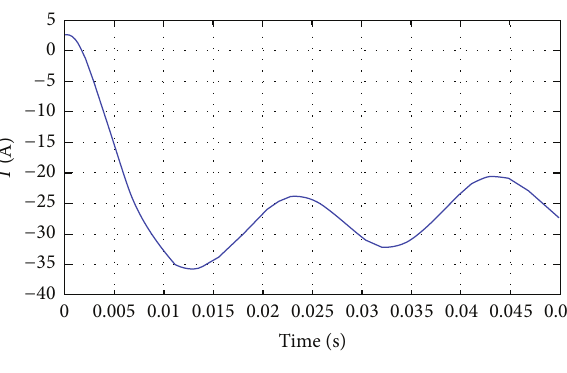
Figure 18: Current flow in the line.